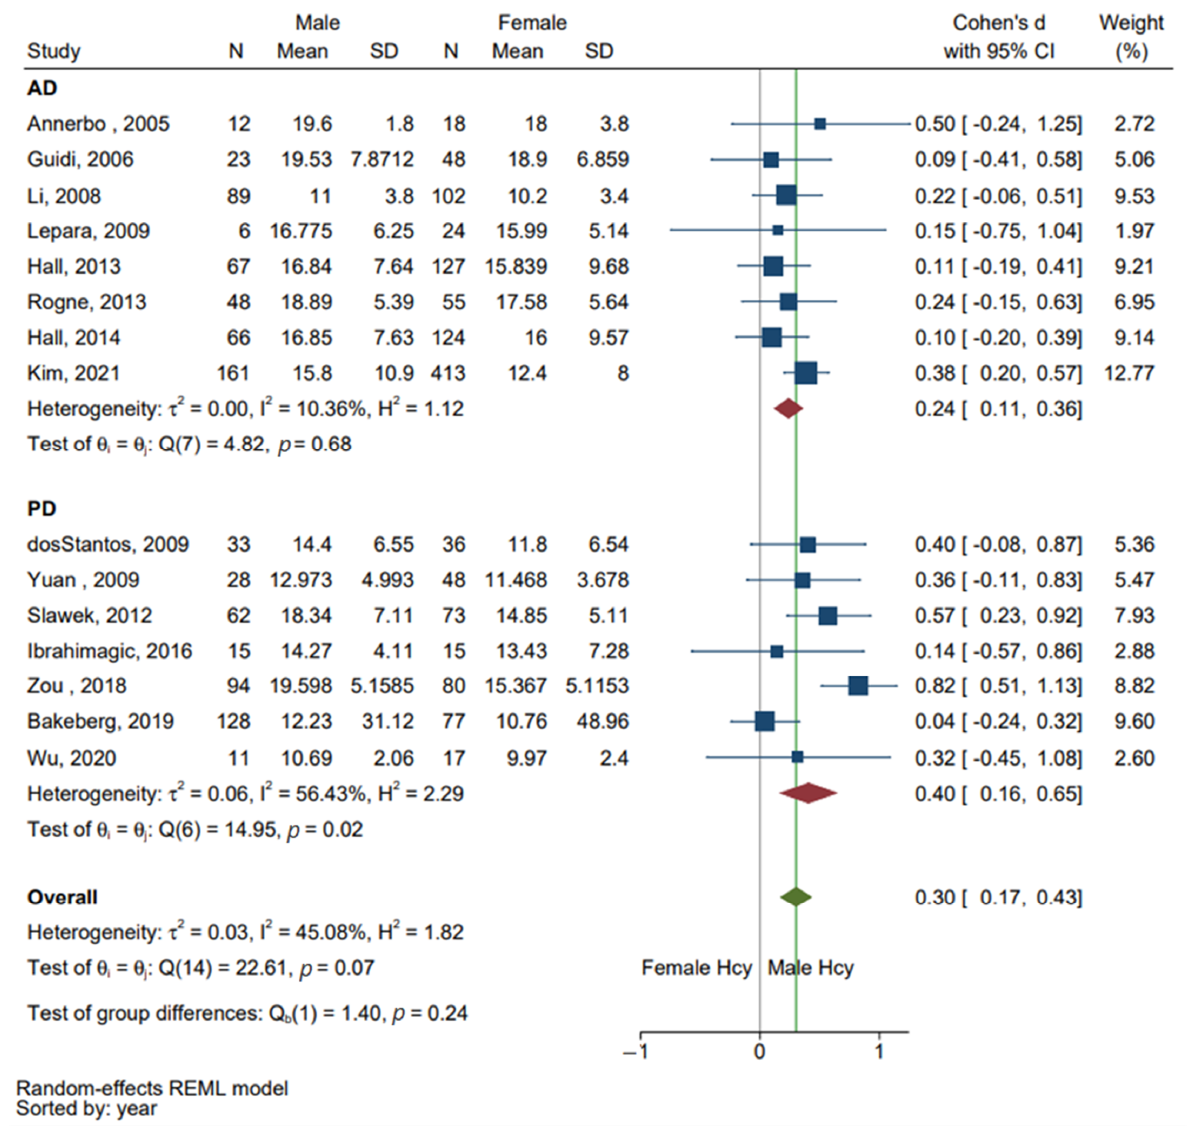
Figure 3. Subgroup analysis of Hcy levels in Alzheimer’s disease (AD) and Parkinson’s disease (